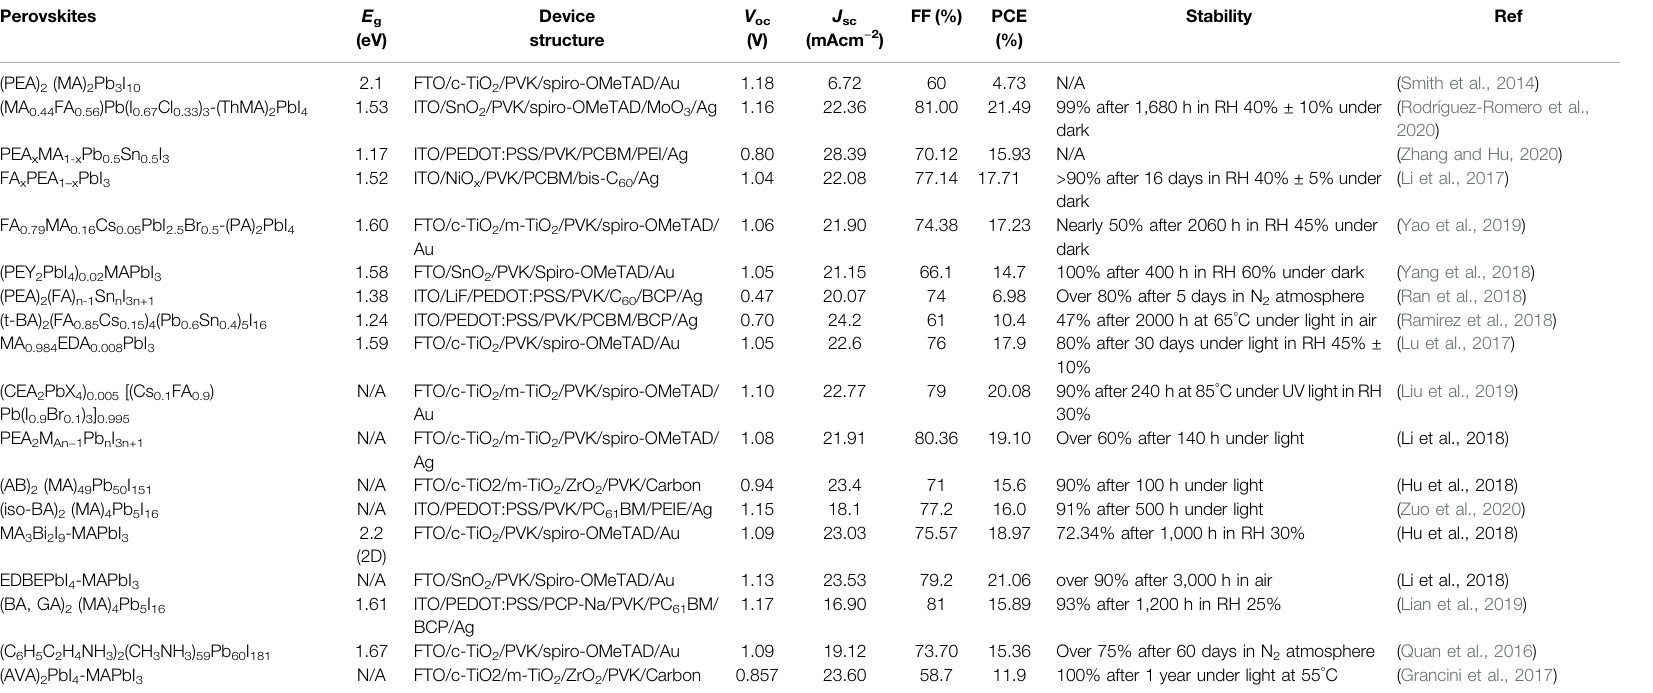
TABLE 1 | Photovoltaic performance and stability summary of representative mixed 2D/3D multidimensional perovskite solar cells Perovskites